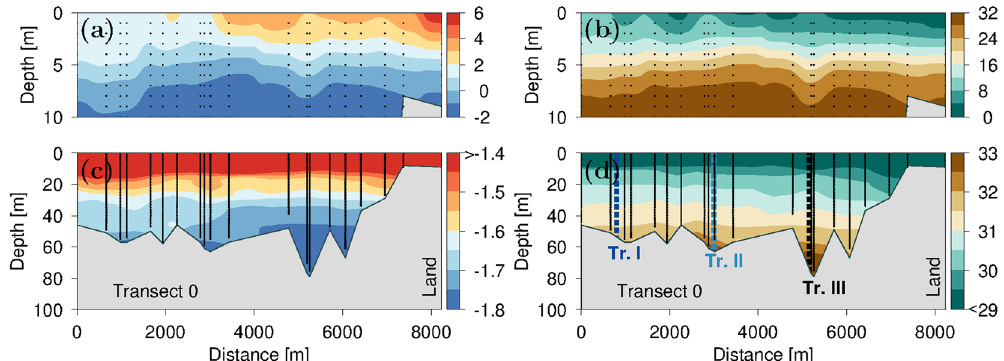
Figure 3. Transect 0 along the terminus. ( a ) Temperature in the upper 10 m, ( c ) in the whole water column and ( b ) salinity in the upper 10 m and ( d ) in the whole water column. Note the varying color scales. The location of Transect I-III are indicated with dashed lines in ( d ). Stations were collected in the period 10–25 August and are indicated with vertical dotted